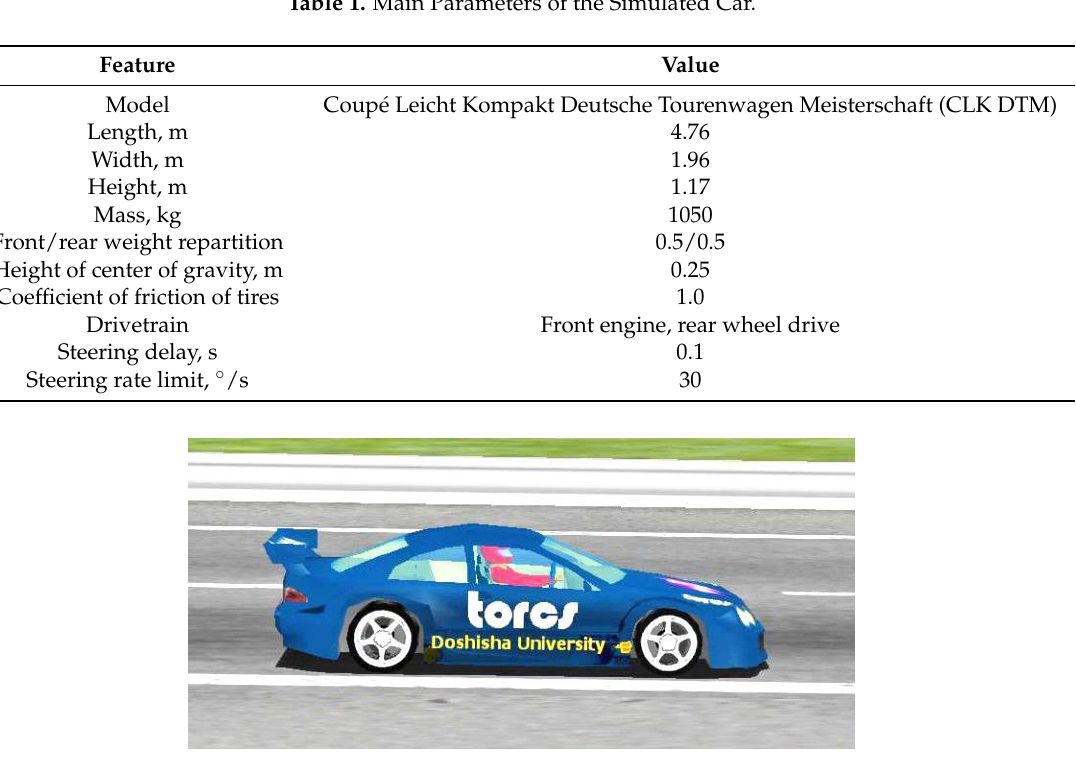
Table 1. Main Parameters of the Simulated Car.